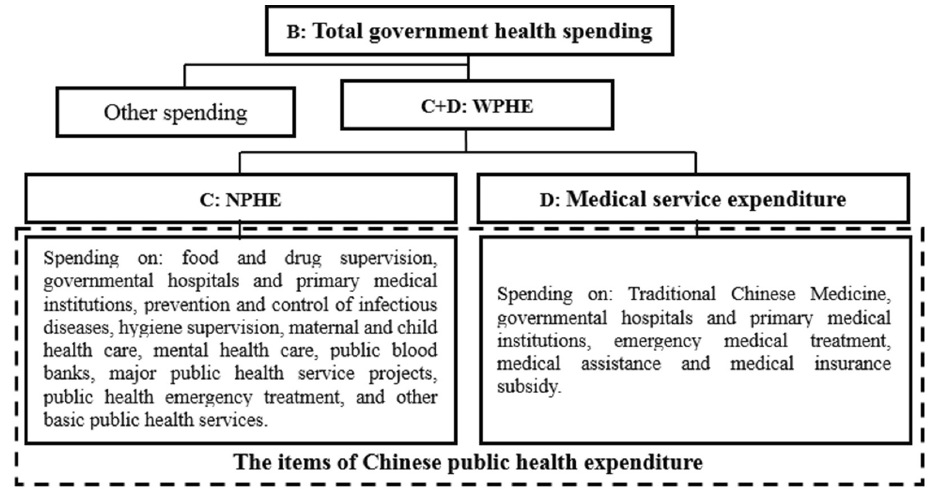
Figure 2. The content of different definitions of public-health expenditure. Note: The implications of B , C , and D in this figure are consistent with those in Figure 1. WPHE is short for wide-caliber public- health expenditure, NPHE is short for narrow-caliber public-health expenditure.